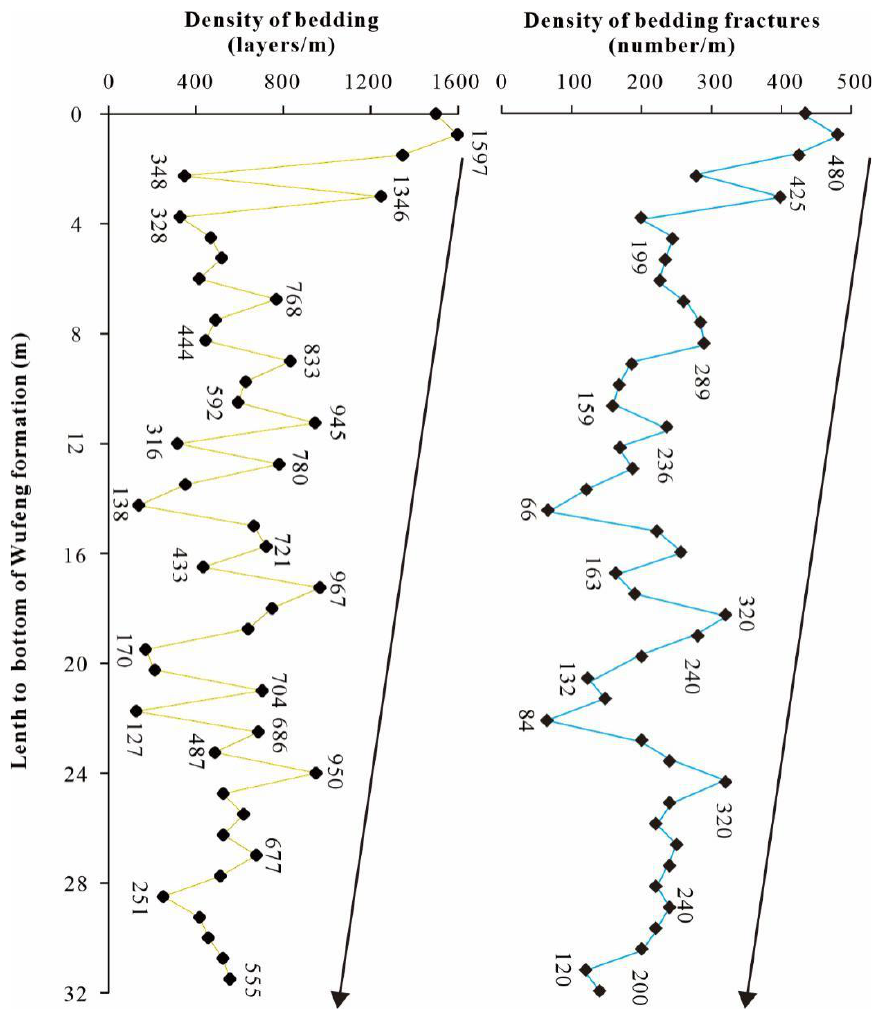
Figure 4. Longitudinal distribution of bedding and fracture density.